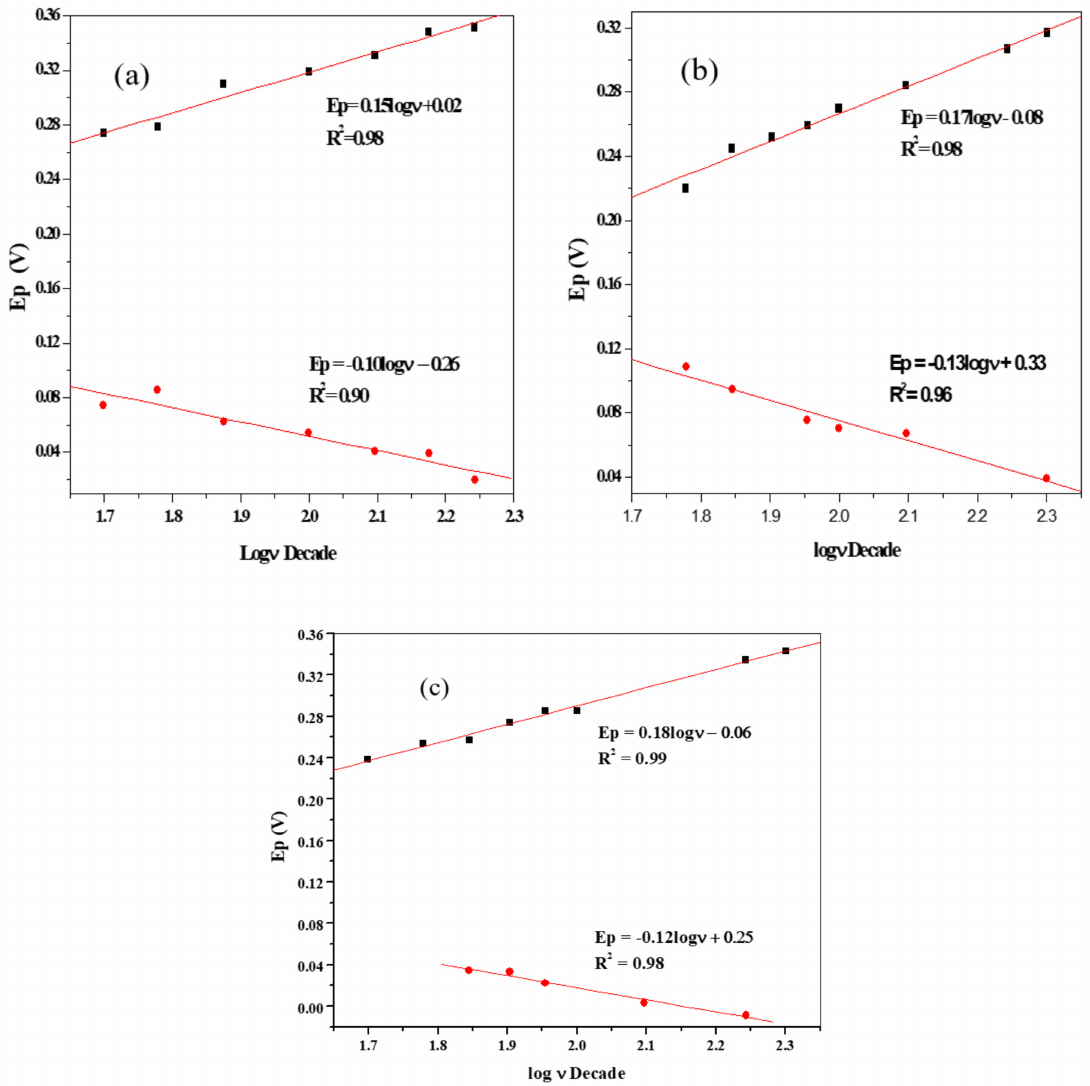
Figure 14. The plot of log of peak potentials vs. scan rate ( a – c ) for the SPCE / LPE / ZnO NPs, SPCE / GPE / ZnO NPs, and SPCE / OPE / ZnO NPs, respectively in 0.1 M KCl / 10 mM K 3 [Fe(CN) 6 ] at pH ≈ 7. From Equation (18), the active surface area (A) is proportional to the value of Ip. At the scan rate of 100 mV / s and the corresponding peak currents as shown in Table 3, using the 10mM (converted to mol / cm 3 ) concentration of the probe, the value of A was calculated from the Randle’s slope for the SPE, SPE / GPE / ZnO NPs, SPE / LPE / ZnO NPs and SPE / OPE / ZnO NPs and found to be 0.82, 2.38, 2.20 and 1.86 mm 2 ,